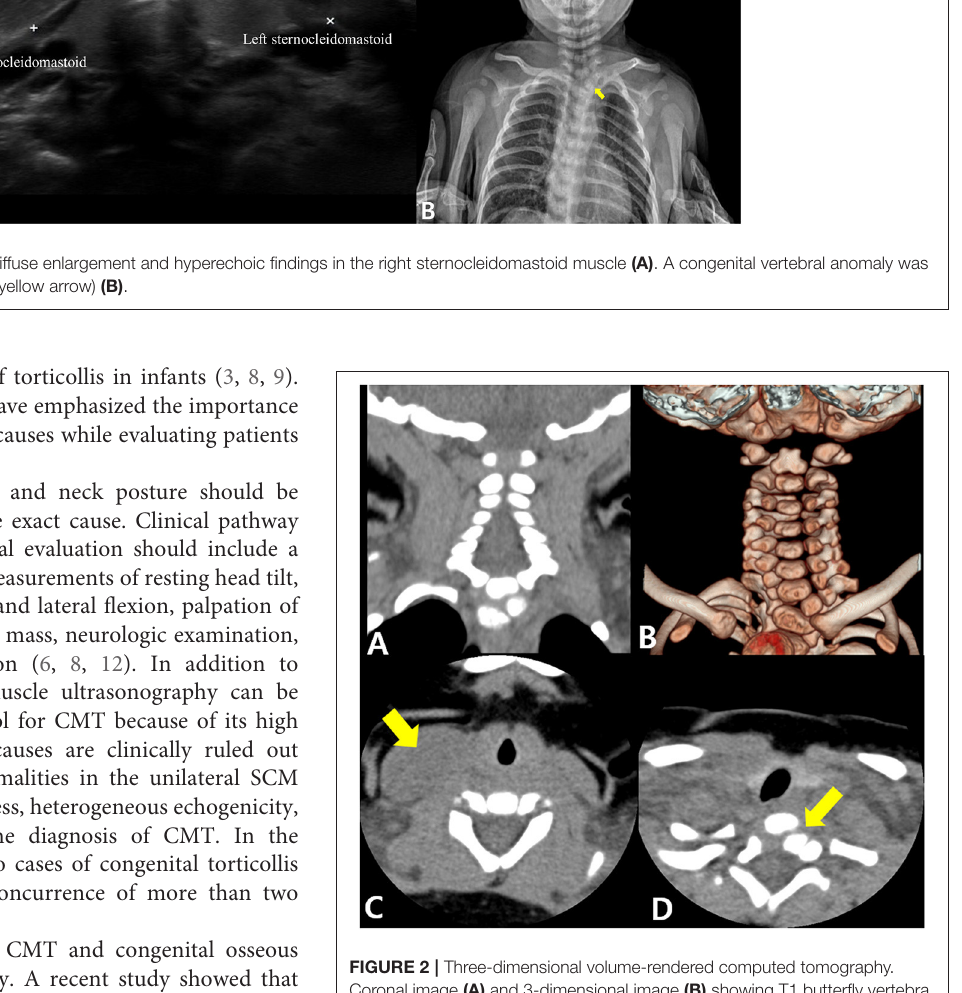
FIGURE 2 | Three-dimensional volume-rendered computed tomography. Coronal image (A) and 3-dimensional image (B) showing T1 butterfly vertebra. Axial cervical image showing enlargement of the sternocleidomastoid muscle (arrow) at the C7 level (C) and a hemivertebra (arrow) at the T1 level (D)